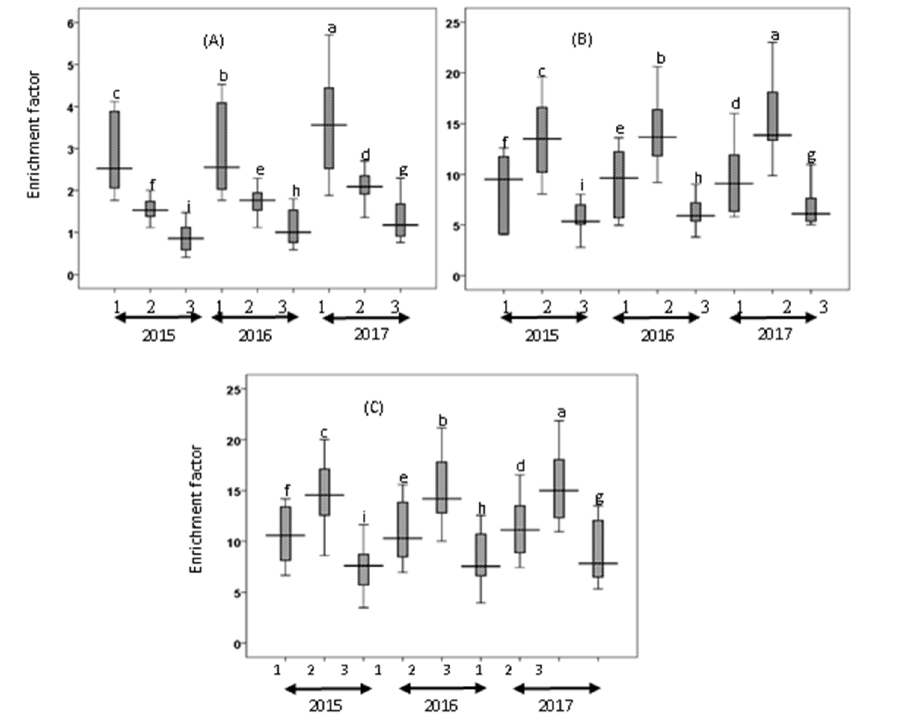
Fig. 2. Boxplot of Cd (A), Pb (B) and Zn (C) enrichment factor in the study area. 1, 2 and 3 represent the stations concerned in this study,